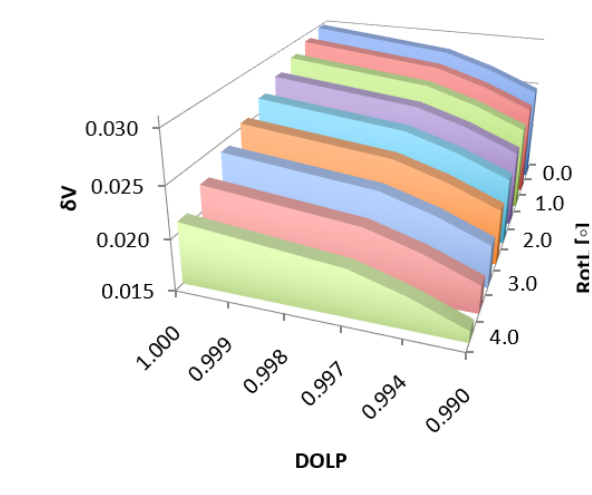
Figure 4 δV depending on variation of DOLP and